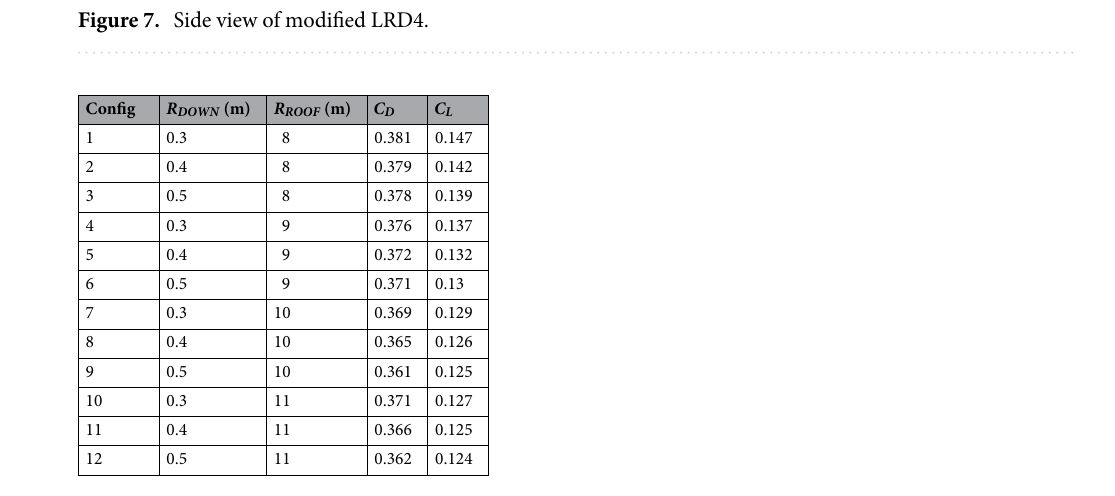
Table 3. C D and C L for many configurations of the exterior modifications of LRD4